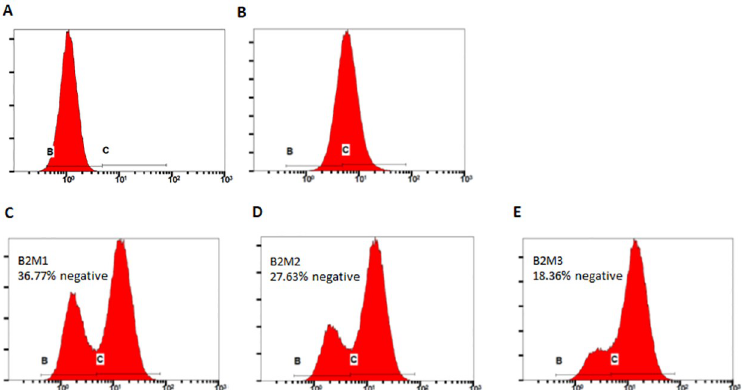
Fig 1. Efficacy of different sgRNAs against B2M in ablating cell surface MHC-I antigen. HEK293T cells were transfected with combination of pCMV-spCas9 and different sgRNAs against B2M (B2M1, C; B2M2, D; and B2M3, E), at a ratio of 1:1.5 for Cas9 and sgRNA plasmid. 5 days after transfection, they were stained with FITC-conjugated antibody against human HLA-A,B&C and run on flow cytometer. A and B were negative (no antibody staining) and positive (wild-type HEK293T cells stained with antibody) controls, respectively.